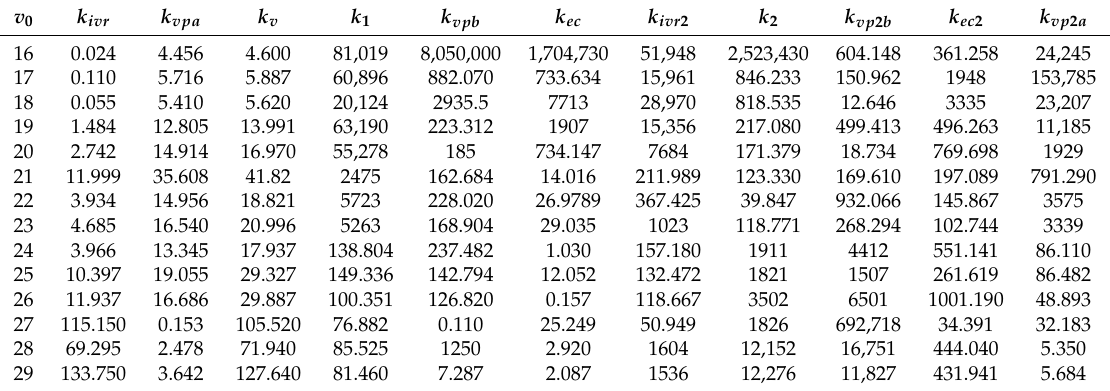
Table 1. Rate constants (in ns − 1 ) obtained by fitting the trajectory surface hopping (TSH) simulation results. v 0 k